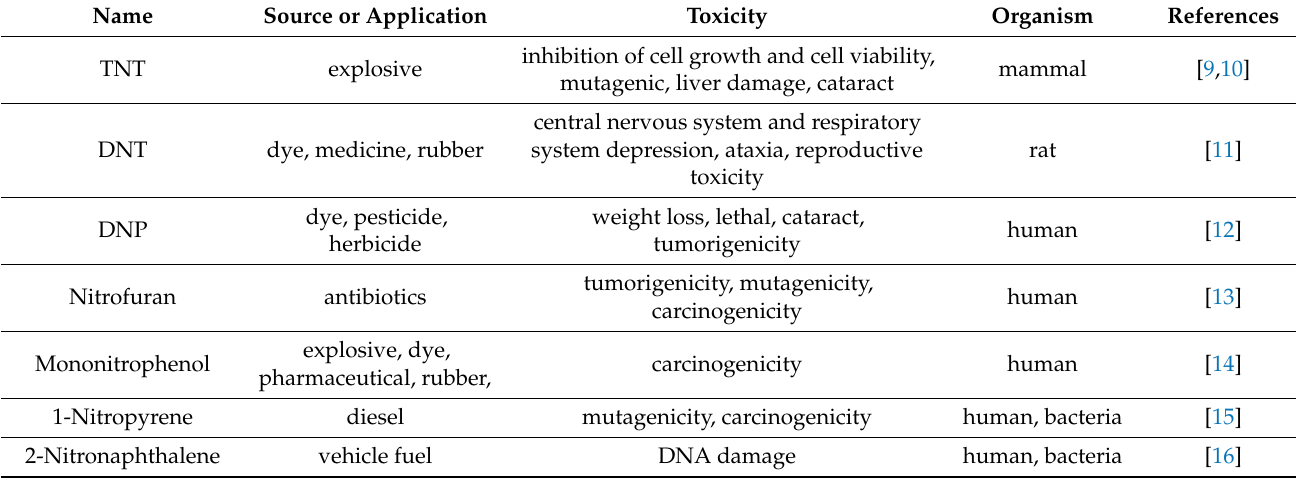
Table 1. Names, sources, applications, toxicity, and research objects of several representative nitroaromatic